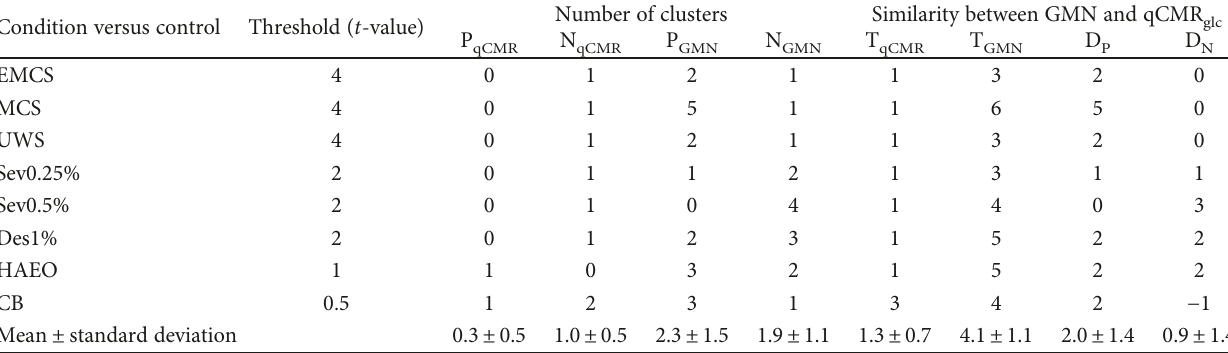
Table 4: Thesholding t -maps in Figures 3 – 6 revealed unidirectional and bidirectional changes, which is illustrated in terms of the number of positive ( P ) and negative ( N ) clusters, where they, respectively, correspond to areas of higher and lower intensities compared to control. See Table 1 for abbreviations of conditions. The positive clusters in the thresholded GMN (P ) versus qCMR (P ) t -maps were 8 times GMN glc qCMR greater, whereas negative clusters in the thresholded GMN (N ) versus qCMR (N ) t -maps were 2 times greater. Similarity between GMN glc qCMR t -maps was assessed by several metrics: (i) the total number of clusters given by the sum of P and N clusters, thresholded GMN and qCMR glc for qCMR ( T = P + N ) and GMN ( T = P + N ) thresholded t -maps; (ii) the di ff erence between the P clusters ( D qCMR qCMR qCMR GMN GMN GMN P glc